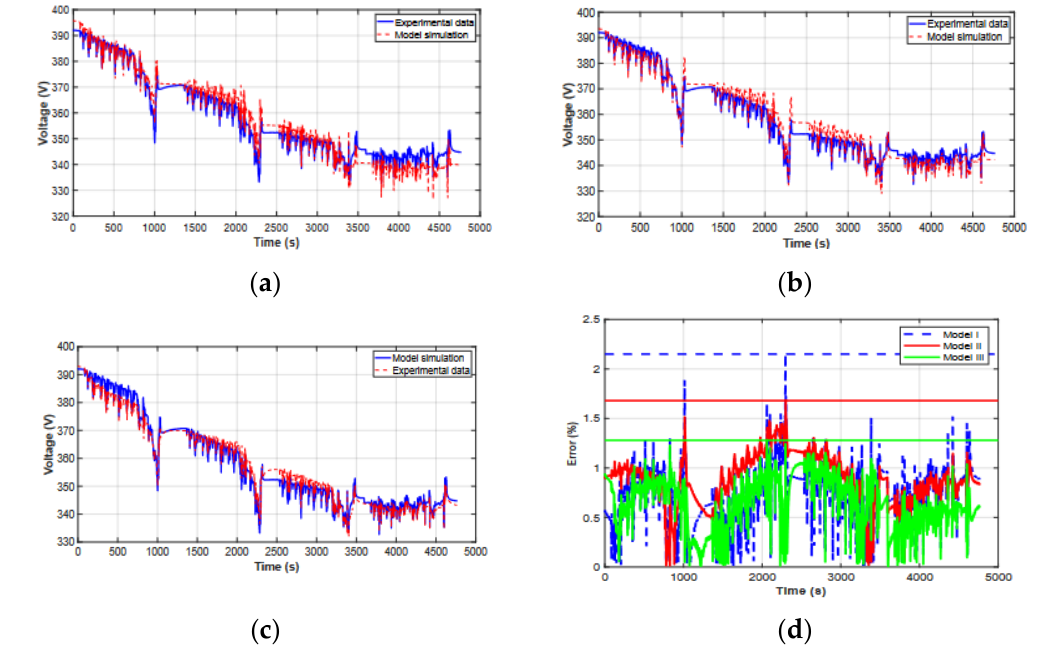
Figure 11. Simulation results following parameter identification using experimental NEDC data: ( a ) experimental and simulated voltage during NEDC identification, Model I; ( b ) experimental and simulated voltage during NEDC identification, Model II; ( c ) experimental and simulated voltage during NEDC identification, Model III; ( d ) Relative absolute error between simulated and experimental voltage for NEDC driving cycle. The horizontal lines are a guide indicating the peak error for each model.